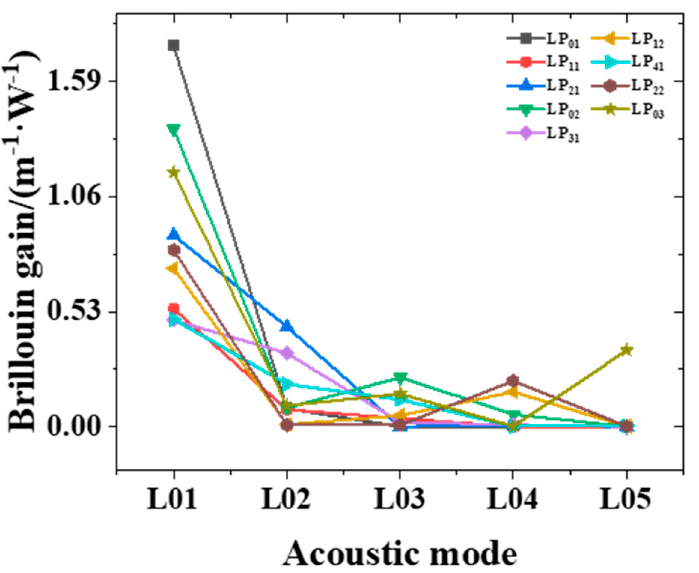
Figure 5. Brillouin gain characteristics of the L 0 n acoustic mode in the case of nine LP mn -LP mn mode pairs.